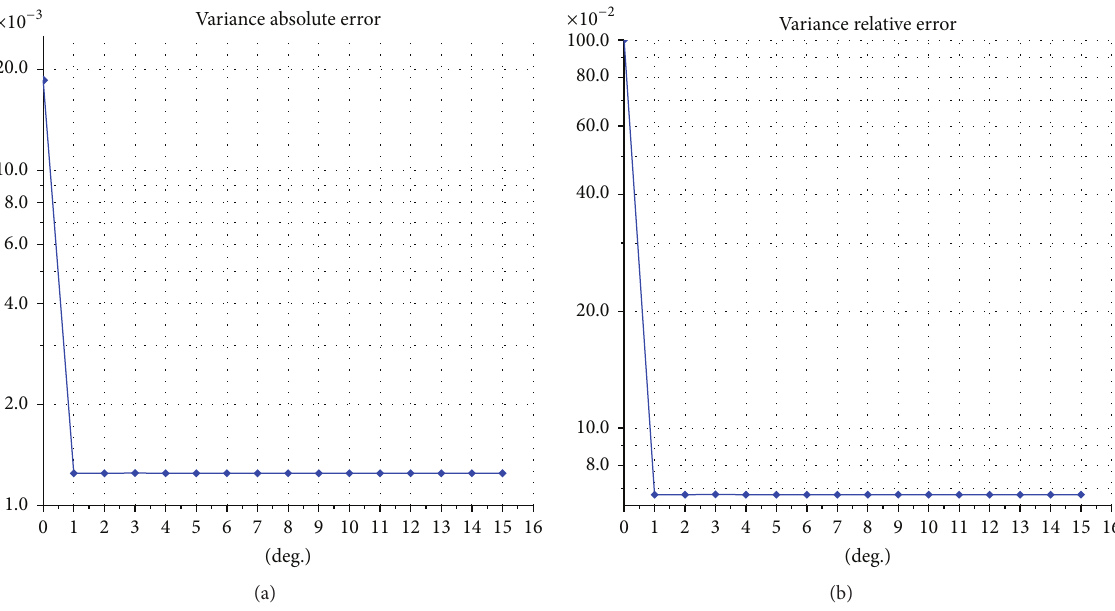
Figure 9: Semilogy scale plot of the absolute error of the variance of 𝑅 (𝑝) 𝑇 evaluated at time 𝑇 = 1 (a) and the absolute relative error of the variance (b) of 𝑅 (𝑝) 𝑇 at time 𝑇 = 1 . In both cases, the parameters of the Vasicek interest rate model are 𝛼 = 0.1 , 𝛽 = 0.2 , and 𝜎 = 0.15 .